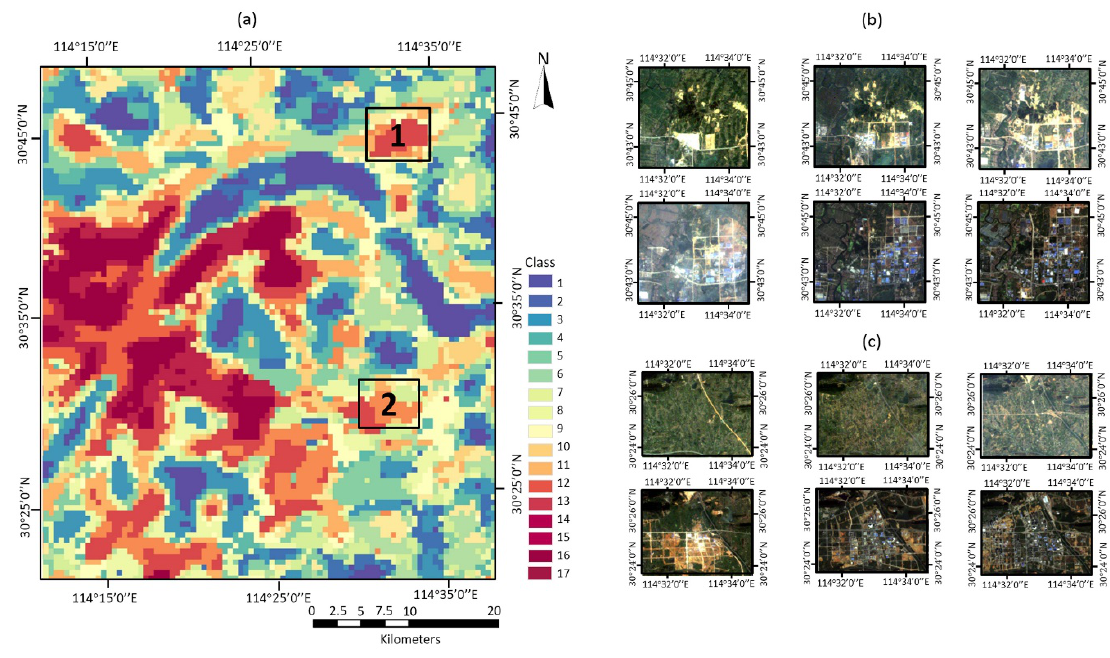
Figure 15. The Land Use and Land Cover (LULC) trajectory analysis of Clusters 15 and 13 by taking two areas as examples. ( a ) The time series clustering result of k -cDBA where the first box represents the example of Cluster 15 while the second represents Cluster 13; the LULC trajectory demonstration of box ( b ) 1 and ( c ) 2.